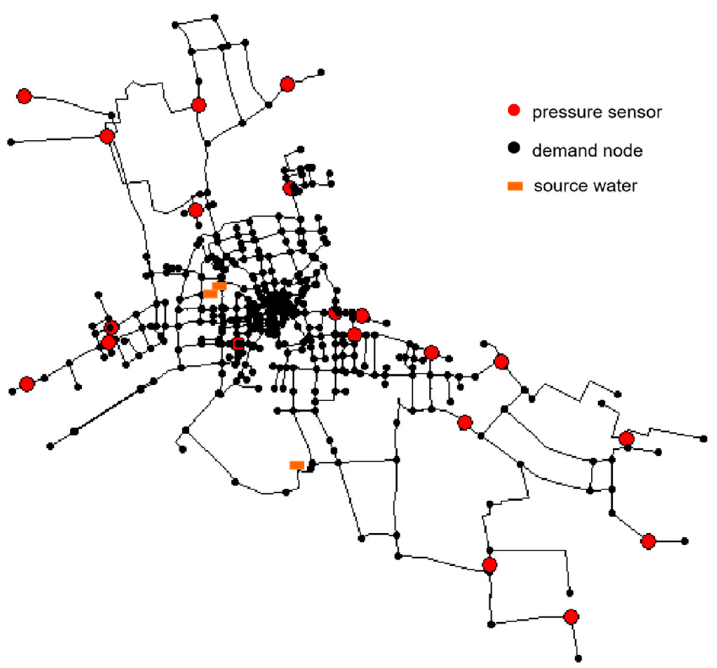
Figure 6. Schematic representation of the water distribution network studied.